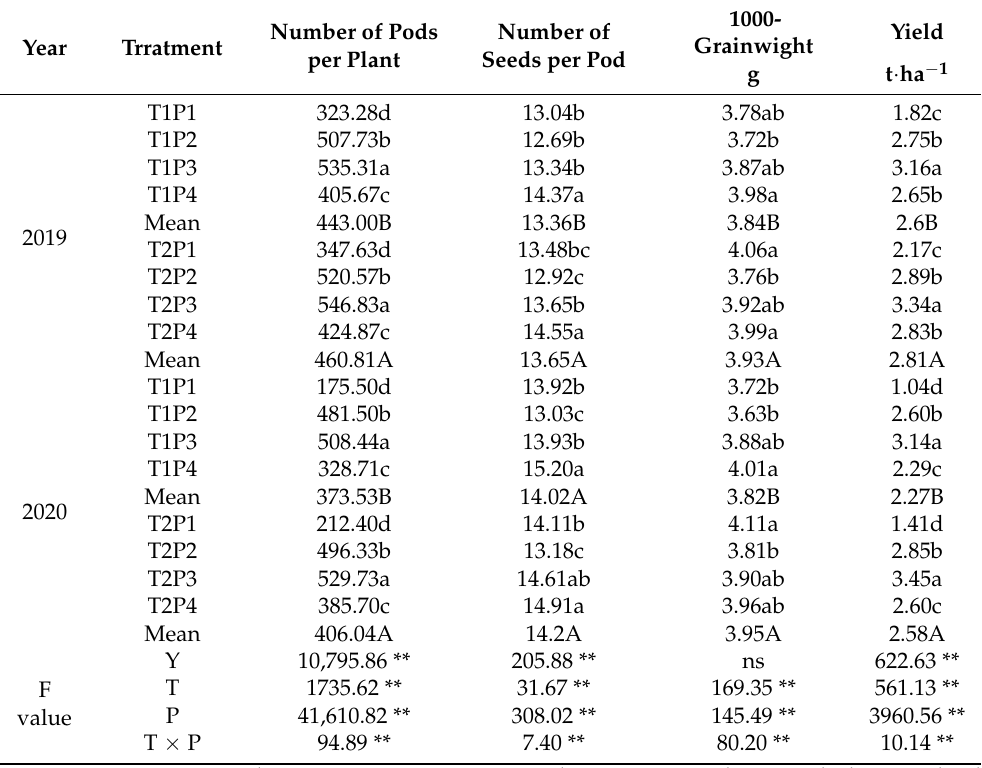
Table 2. Rapeseed yield and its conponment under different treatments in 2019 and